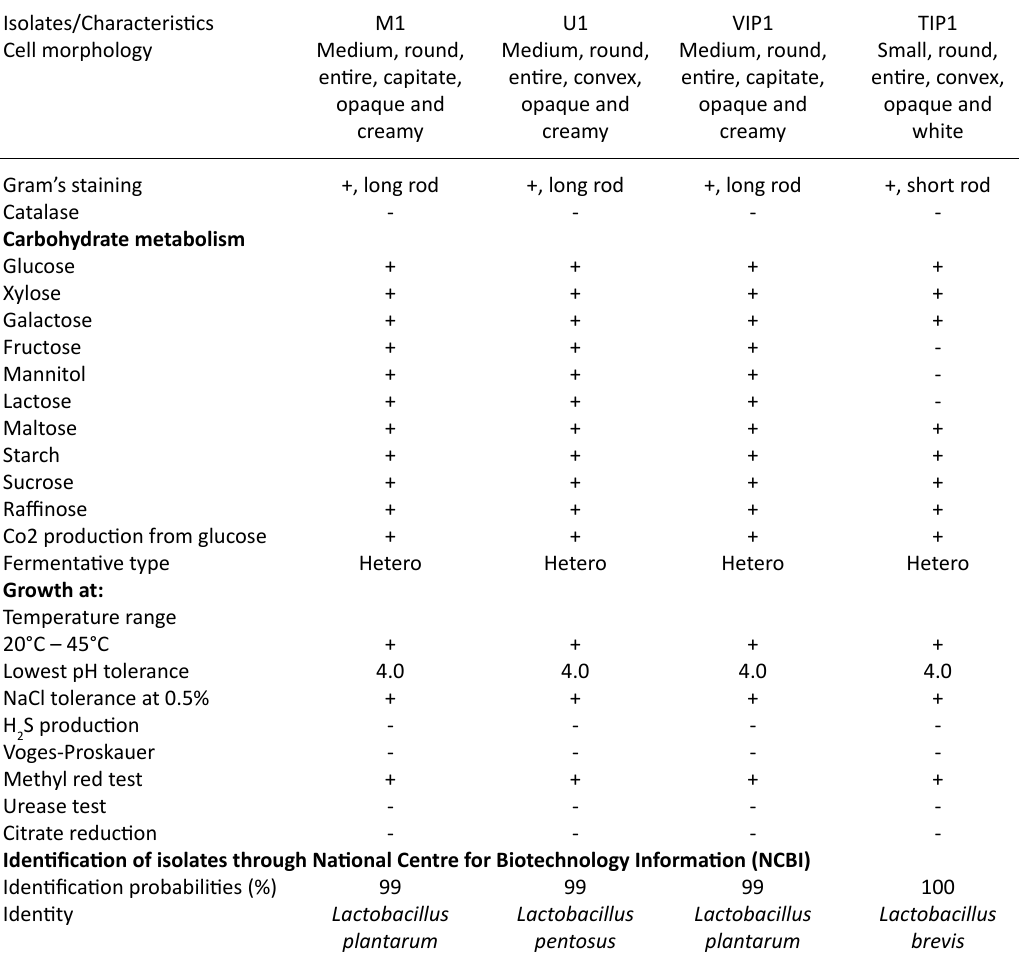
Table 2. Characteristics and identification profile of the isolates Isolates/Characteristics